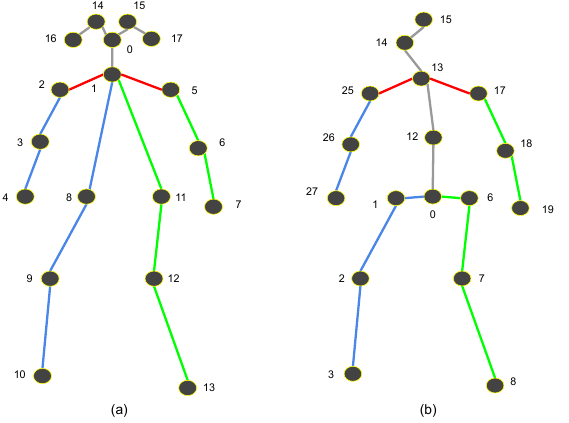
Figure 3. Skeletal model difference. ( a ) COCO dataset parts index numbers. ( b ) H3.6M dataset parts index numbers.